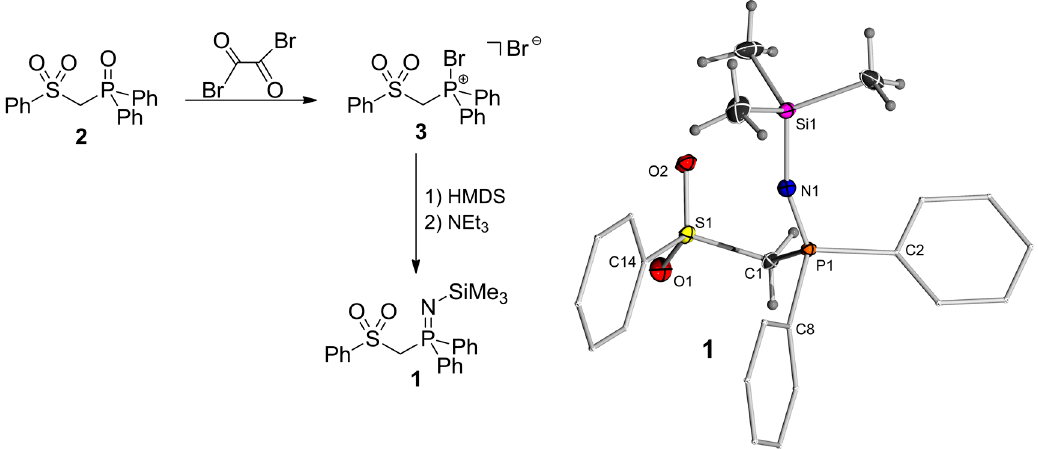
Figure 3. Synthesis of the α -iminophosphoryl-substituted sulfone 1 and molecular structure of 1 . Ellipsoids drawn at the 50% probability level. Hydrogen atoms (except for those at C1) omitted for clarity. Selected bond lengths [Å] and angles [°]: C1–S1 1781(2), C1–P1 1844(2), S1–O1 1446(1), S1–O2